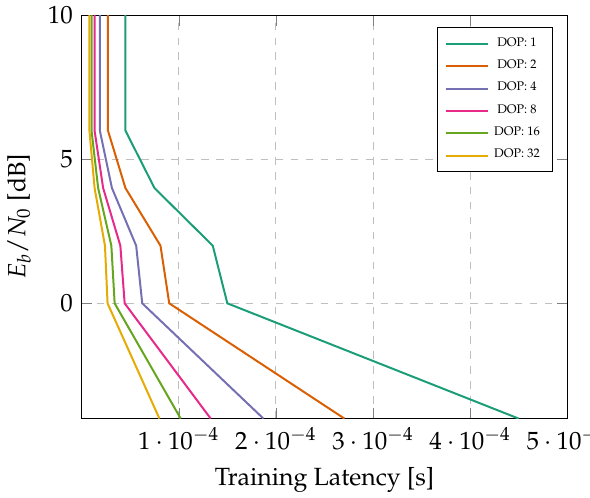
Figure 12. Influence of DOP on convergence latency for a target BER of